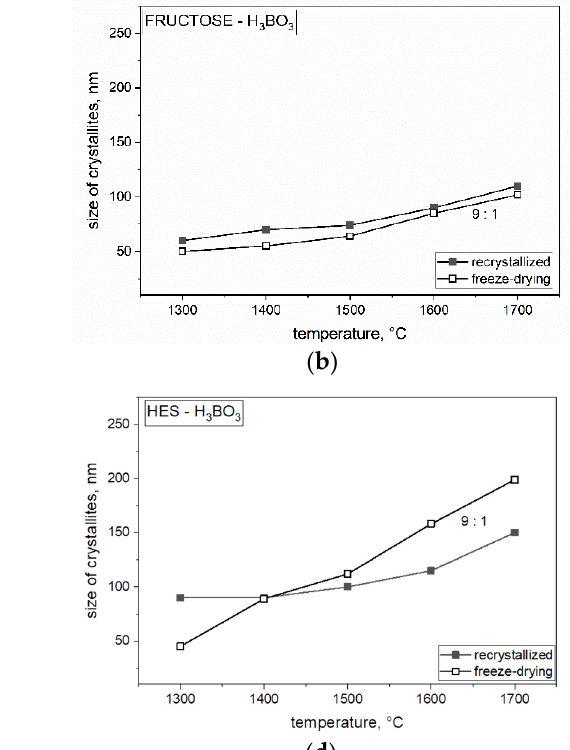
Figure 9. The changes in the crystallize size of boron carbide obtained with different precursors mixed with boric acid with a molar ratio of 9 C:1 B using both methods and heat treatment from 1300 to 1700 °C: ( a ) glucose, ( b ) fructose, ( c ) dextrin, and ( d )